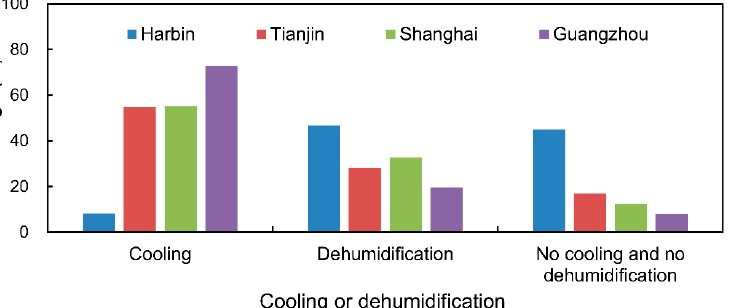
Figure 2. Percentage of the degree days of cooling, dehumidification, and no cooling and no dehumidification of the four selected cities.